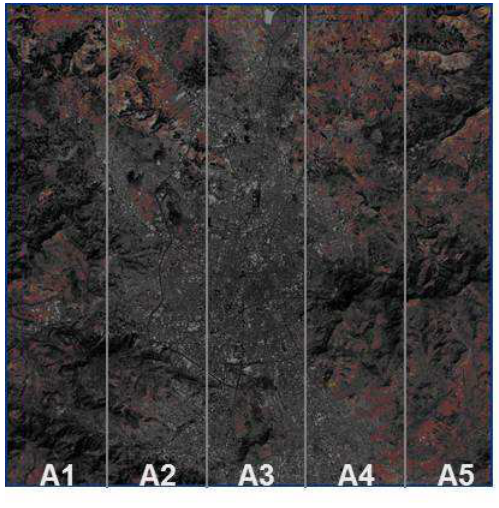
Figure 7 a : Sanaa Pleiades image (5 strips A1 to A5)